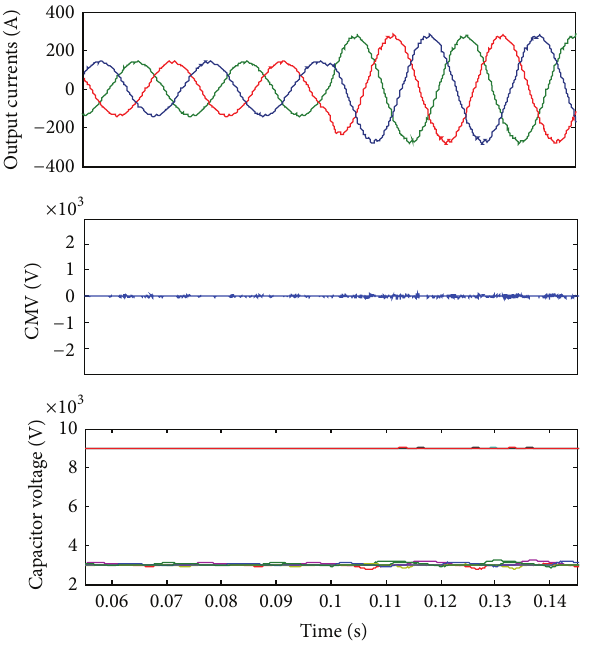
Figure 7: Simulation results from half to full loads.